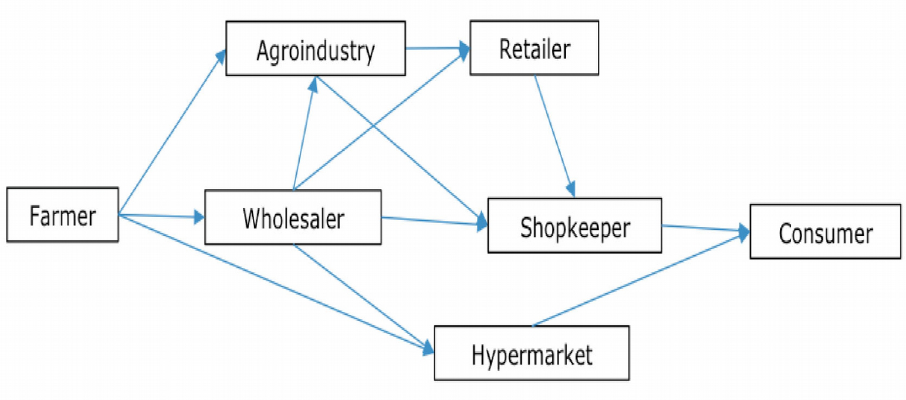
Figure 1. Supply Chain of pesishable Fruit,